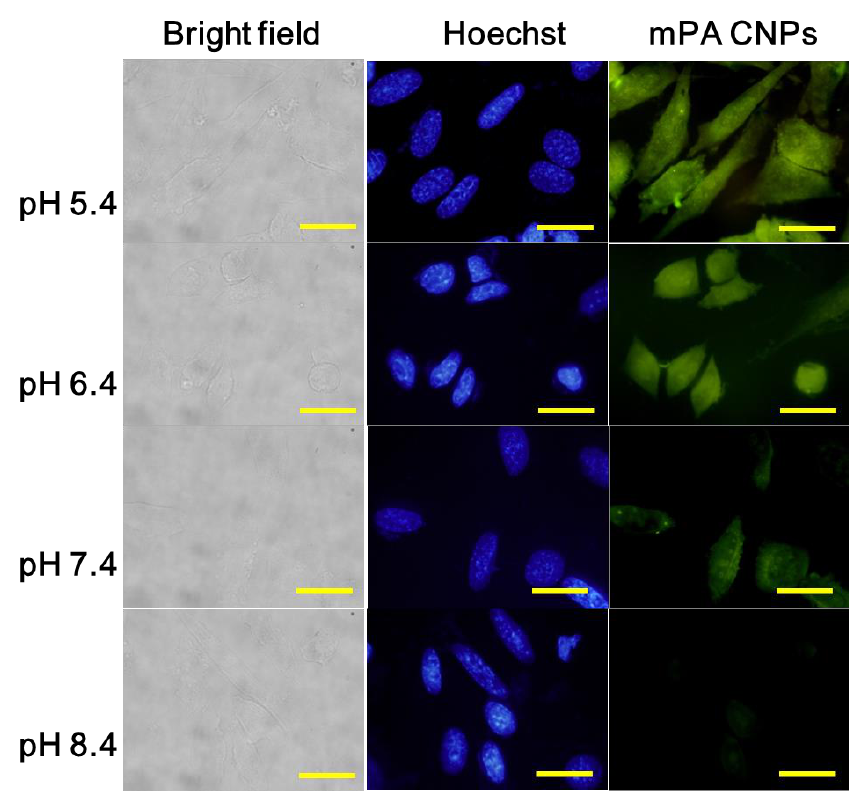
Figure 3. Fluorescence microscopic images of Tramp C1 cells stained with mPA CNPs (5 μg mL −1 ) were exposed to various PBS solutions at pH 5.4, 6.4, 7.4, and 8.4 for 2 h . From left to right were were exposed to various PBS solutions at pH 5.4, 6.4, 7.4, and 8.4 for 2 h. From left to right were different channels: bright field, blue channel (λ ex = 350‒380 nm, λ em = 420 nm) and green channel (λ ex different channels: bright field, blue channel ( λ ex = 350–380 nm, λ em = 420 nm) and green channel = 470‒490 nm, λ em = 520 nm). The scale bar denotes 20 μm. ( λ ex = 470–490 nm, λ em = 520 nm). The scale bar denotes 20 µ